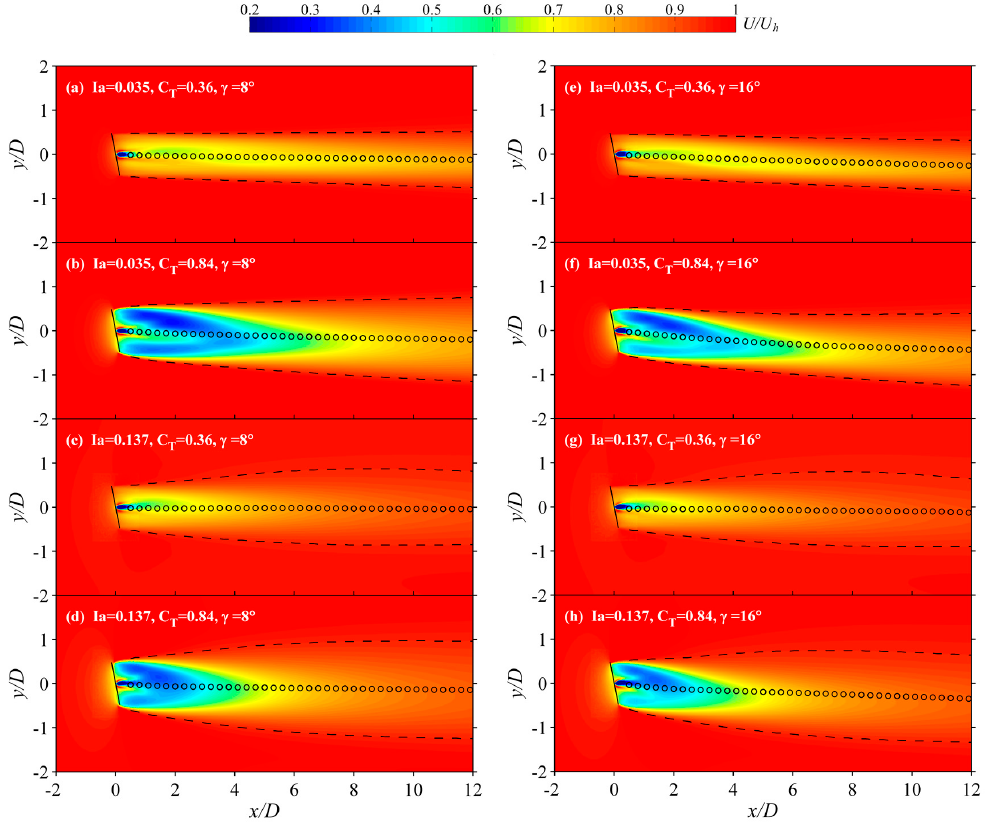
Figure 6. Contours of normalized mean velocity U / U h and wake deflections in the horizontal x - y plane at the hub height. Solid lines represent the wind turbine rotors. Dashed lines and open circles indicate the wake boundaries and wake center trajectories, respectively.